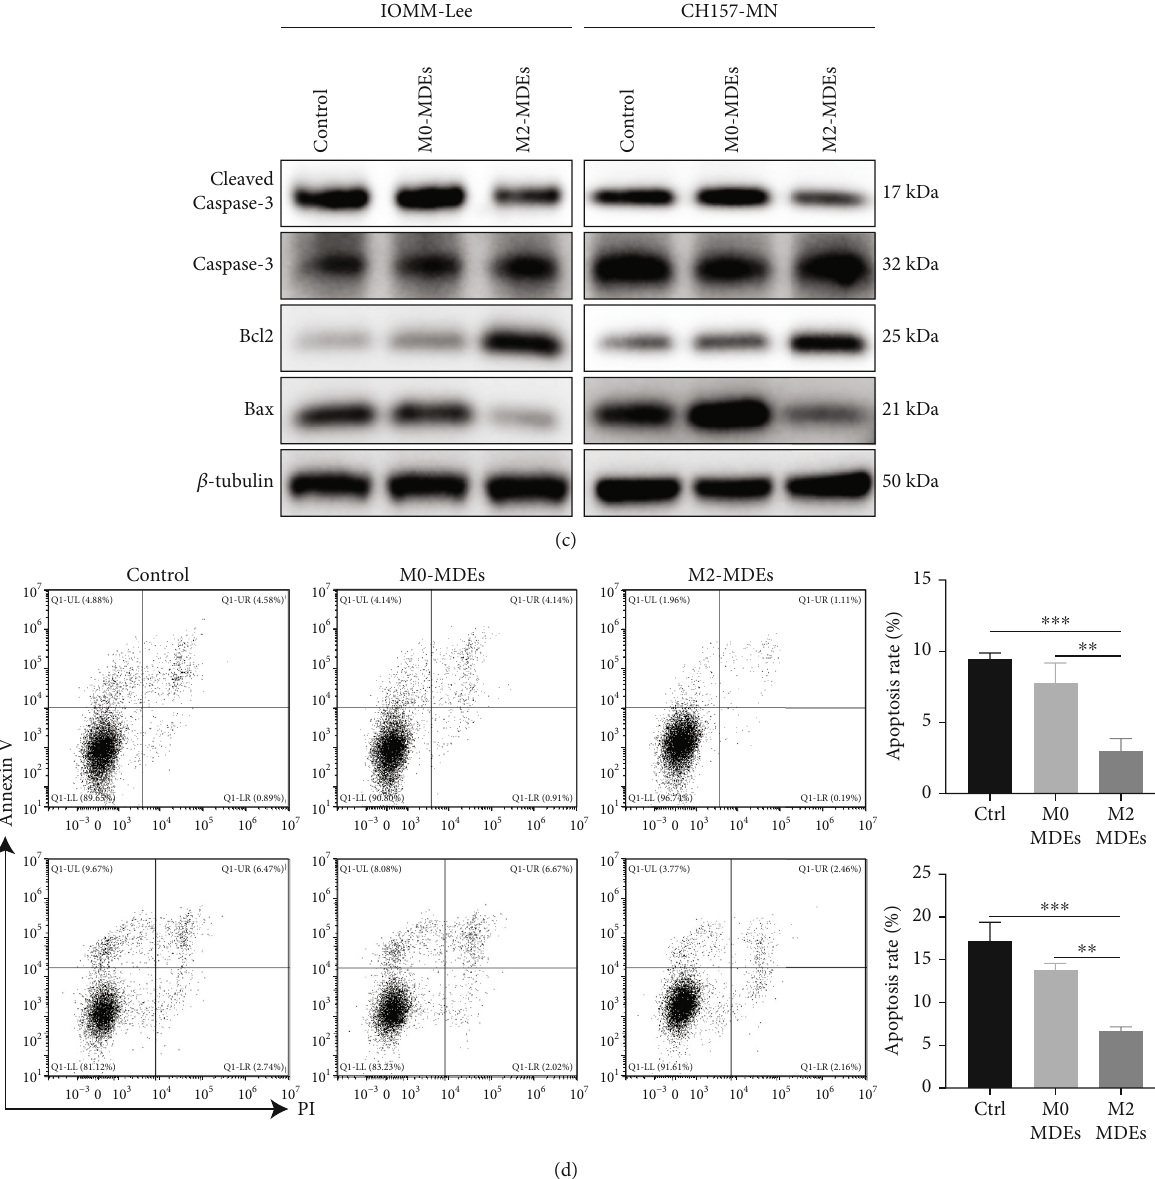
Figure 2: M2-macrophage-derived exosomes promote meningioma cell proliferation and inhibit apoptosis. (a) Detection of cell viability during 24 – 72h proliferation in IOMM-Lee and CH157-MN cells using CCK-8 assay. (b) EdU staining and fl ow cytometry to detect the fraction of proliferating cells in IOMM-Lee and CH157-MN cells. (c) Western blotting was used to detect the protein expression levels of caspase-3, cleaved-caspase-3, Bcl2, and Bax. (d) FITC-conjugated Annexin V kit was used for labeling apoptotic cells in IOMM-Lee and CH157-MN cells, and distribution was detected by fl ow cytometry. ∗ p < 0 : 05 , ∗∗ p < 0 : 01 , ∗∗∗ p < 0 : 001 , vs. the control and M0-MDE